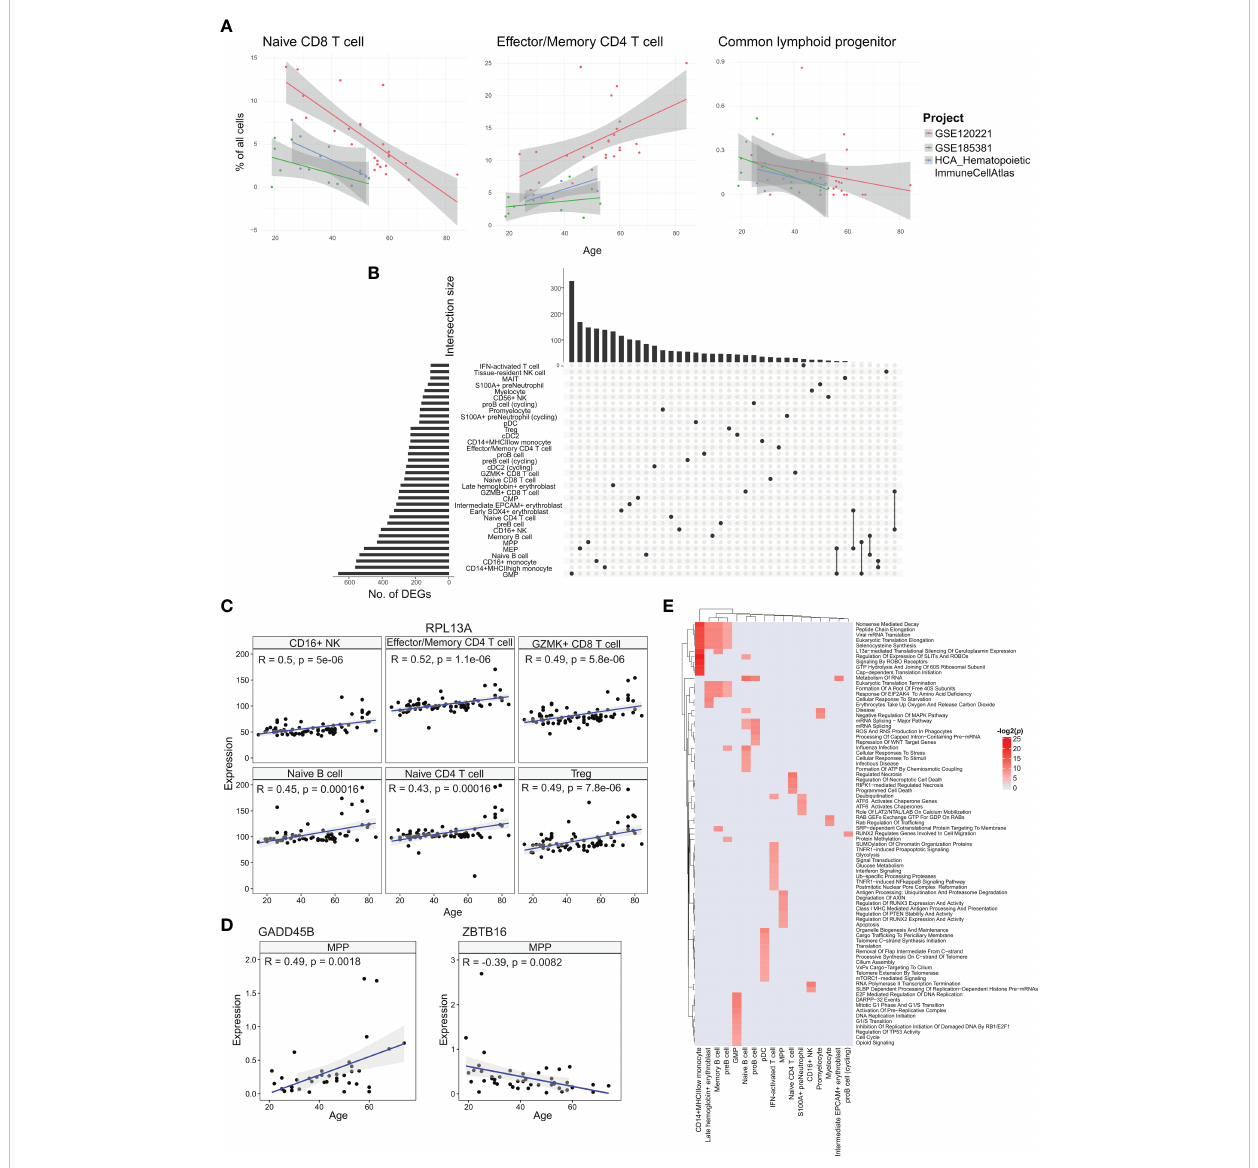
FIGURE 3 Analyses of age-correlated changes in the bone marrow. (A) Regression plots showing signi fi cant changes in cell type frequencies with respect to age for naïve CD8 + T cell, effector/memory CD4 + T cell, and common lymphoid progenitor in the bone marrow. (B) UpSet plot with set size depicting the number of signi fi cant age-related DEGs for each of the respective cell types and intersection size illustrating the number of age- related DEGs unique to a cell type or shared with other cell types depending on which cells have been fi lled in the respective columns. (C) Regression plots showing the upregulation of sample averaged RPL13A expression for multiple cell types across age. (D) Regression plots of sample averaged expression of GADD45 and ZBTB16 . (E) Heatmap of age-associated dysregulated pathways in different cell